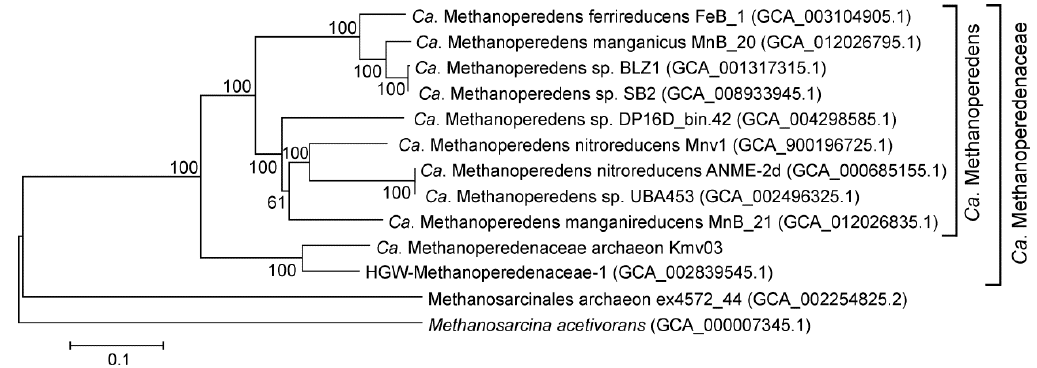
Figure 3. Phylogenetic placement of the Ca. Methanoperedeaceae archaeon Kmv03. The genome tree was inferred using the maximum-likelihood method with a concatenated set of 122 archaeal-specific marker genes. GenBank assembly accession numbers are shown in parentheses after the genome names. The genome of Methanosarcina acetivorans was used to root the tree.